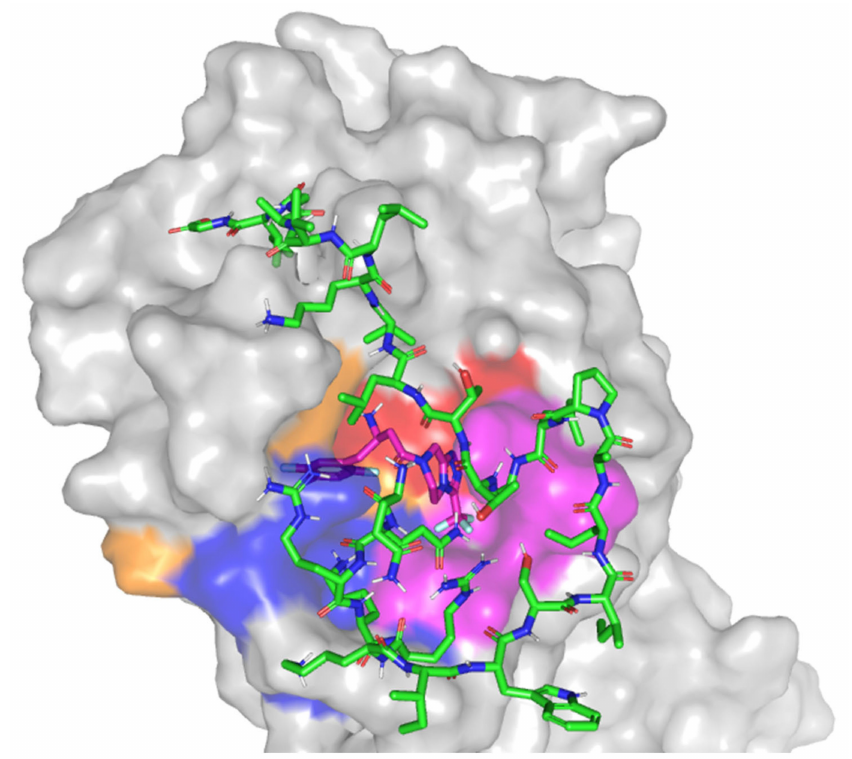
Figure 9. Superimposed conformations of docking ligands within SARS-CoV-2 3CL pro main protease active site (PDB code: 6lu7). Docked ligands are shown as sticks 3D-representation (Melittin = green and sitagliptin = magenta) at the binding site of target protein (gray surface) representing different colored sub-pockets (S1’ = red; S1 = magenta; S2 = orange; S3 = blue).